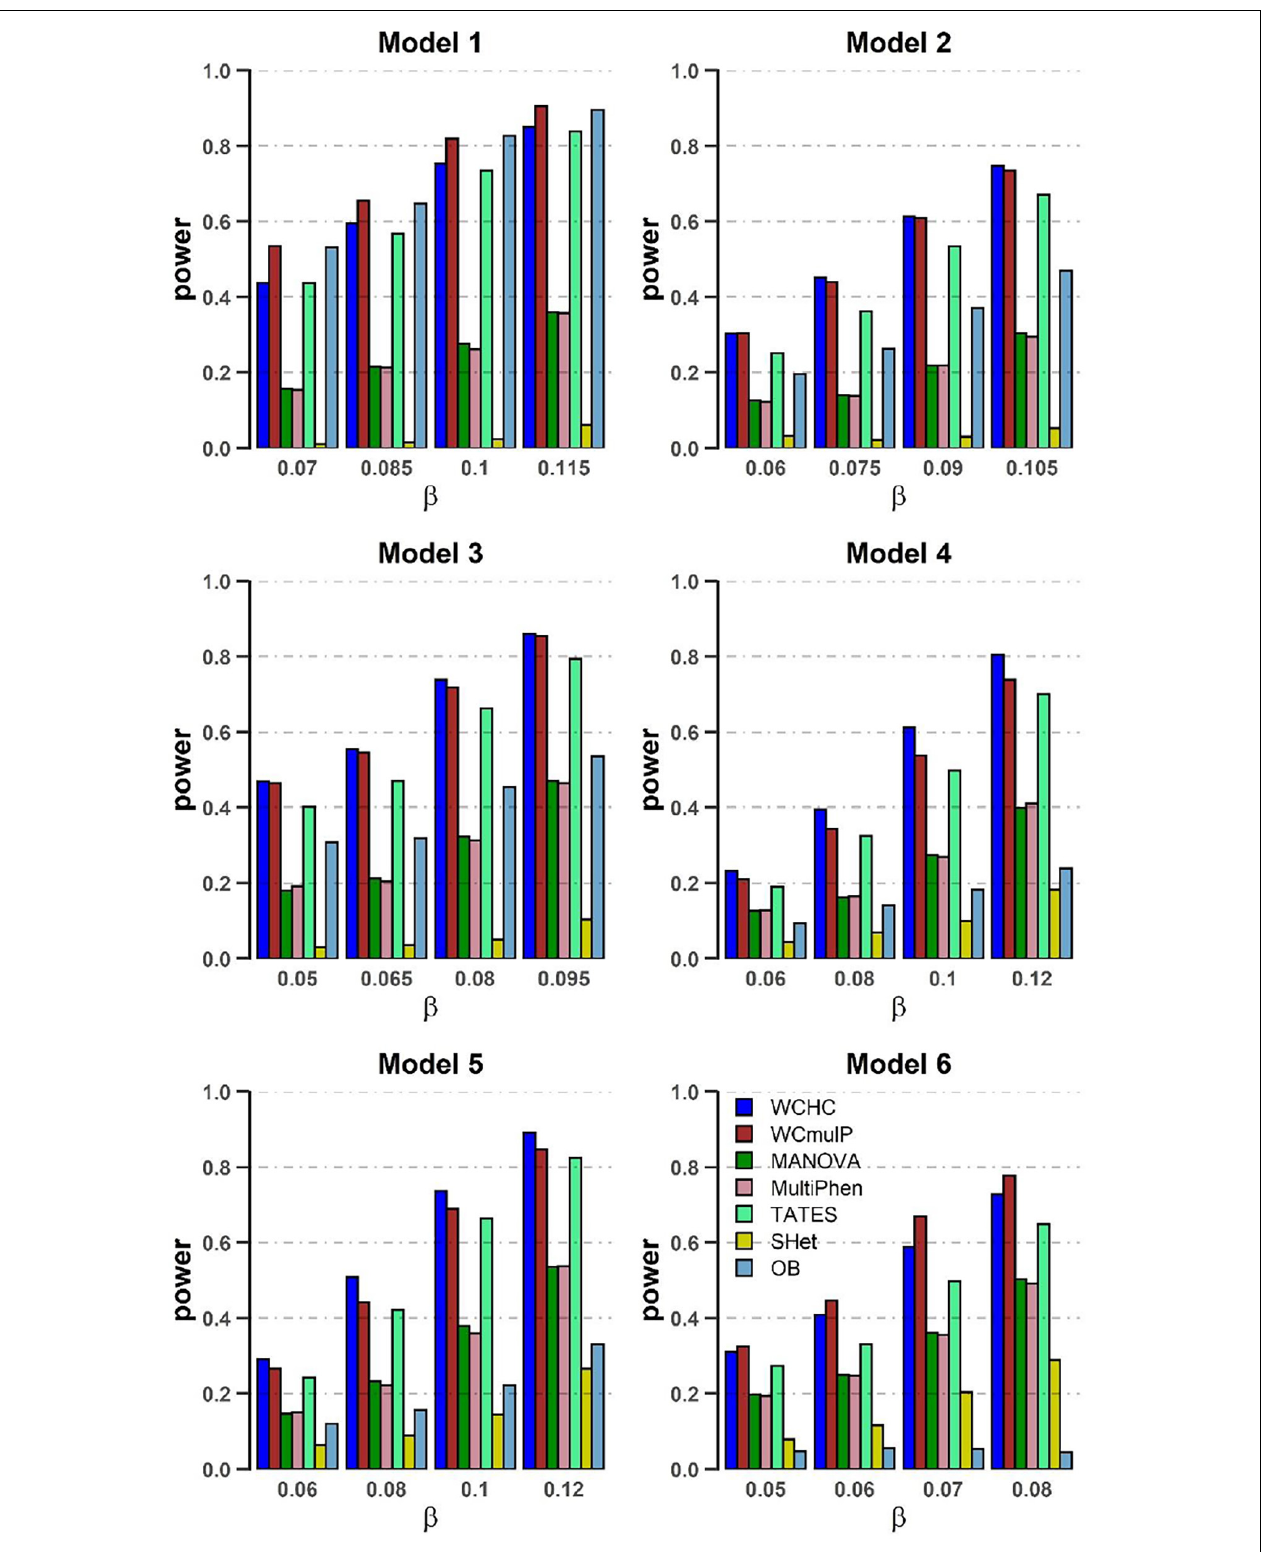
FIGURE 2 | Power comparisons of the seven methods as a function of β in the six models. Sample size is N = 1,000, the number of phenotypes is M = 32, c 2 = 0.5, ρ c 2 = 0.1, and MAF = 0.3. The power of all the seven methods is estimated by 1000 replicated samples at a significance level of 0.05.